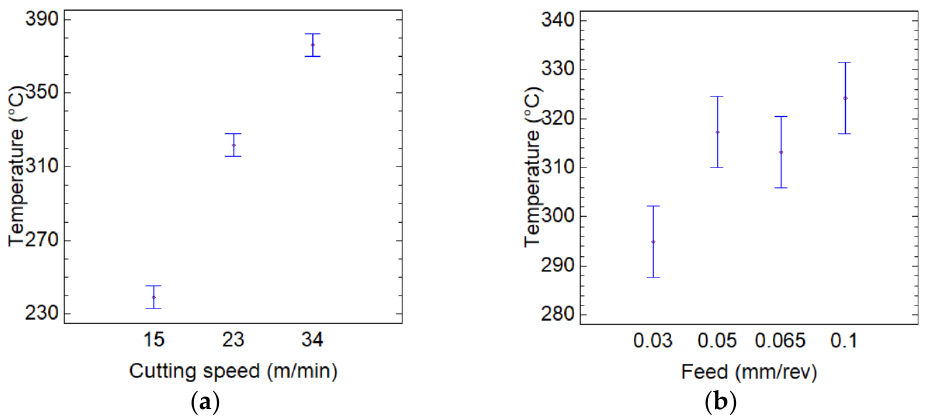
Figure 7. Means plots of the influences of the cutting speed and feed on the cutting temperature: ( a ) temperature vs. cutting speed; ( b ) temperature vs. feed. ( a ) temperature vs. cutting speed; ( b ) temperature vs.